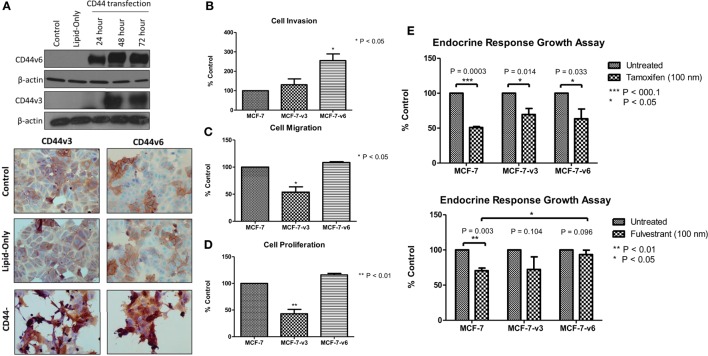
Overexpression of CD44v6, but not CD44v3, in MCF-7 cells promotes an invasive phenotype. (A) Transfection of MCF-7 cells with CD44v3 or CD44v6 resulted in expression of these proteins to a similar extent as seen in the Tam-R and Fas-R cells but did not alter the expression of other CD44 variants. (B) Overexpression of CD44v6 resulted in a gain of invasive capacity in MCF-7 cells, in contrast to CD44v3 overexpression that reduced the migratory (C) and proliferative (D) capacity of these cells. MCF-7 cells overexpressing CD44 isoforms were exposed to tamoxifen or fulvestrant for 7 days and their growth determined by cell counting. (E) CD44v6-overexpressing MCF-7 cells exhibited a reduced response to fulvestrant, but not tamoxifen, compared to the control or CD44v3-overexpressing cells.